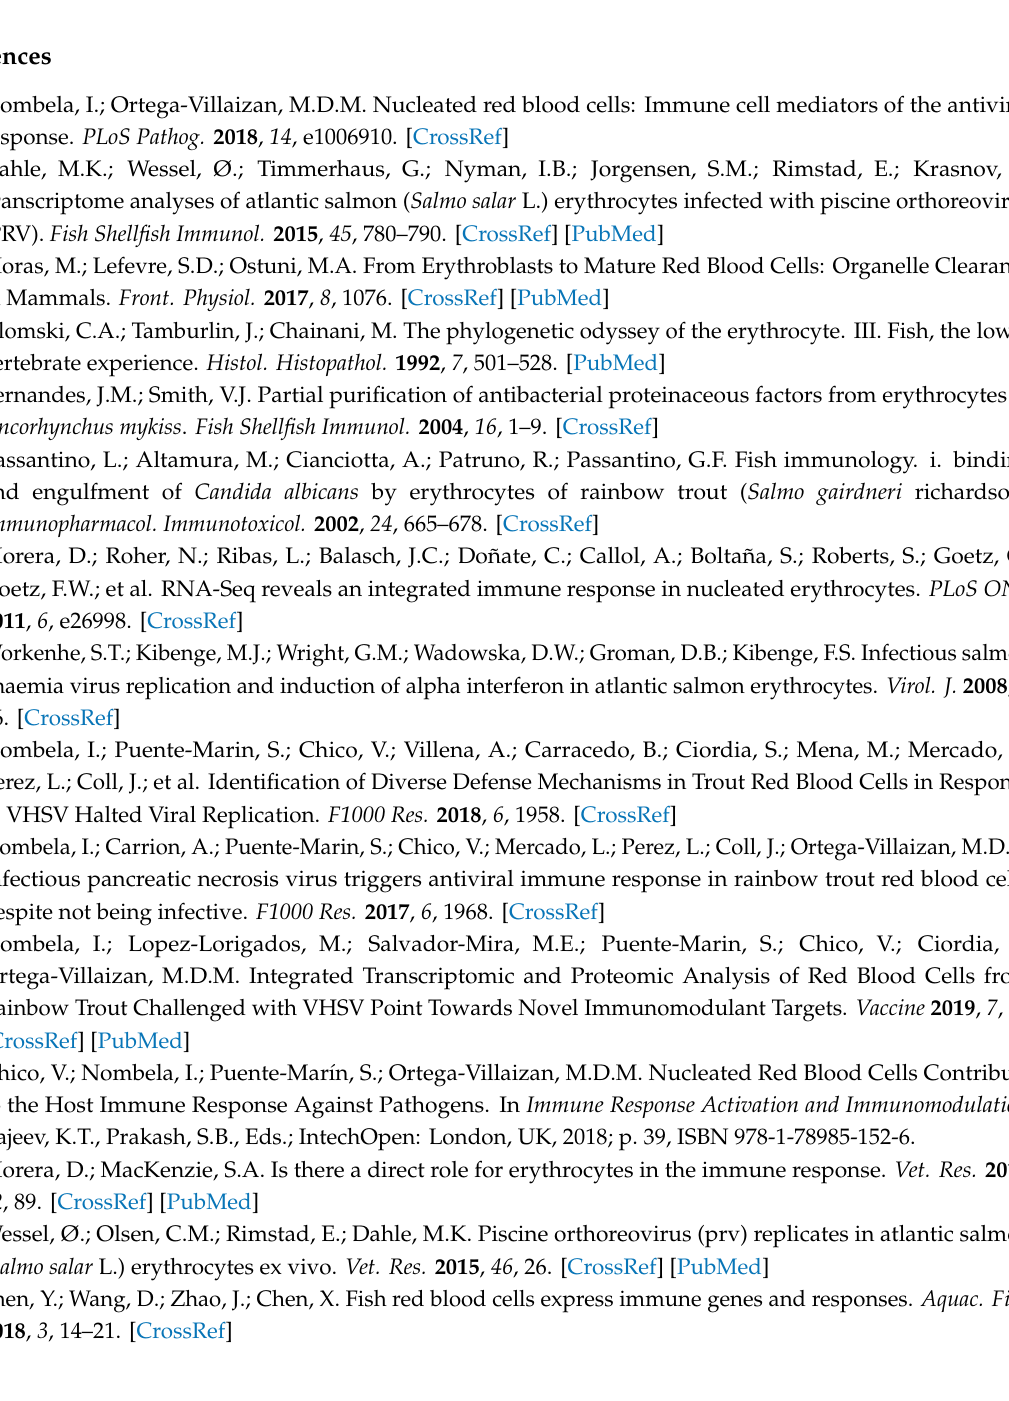
control group. Figure S3. The top 20 enriched KEGG pathways of di ff erentially expressed genes (DEGs). The color and size of the dots indicate p -value and DEG number,